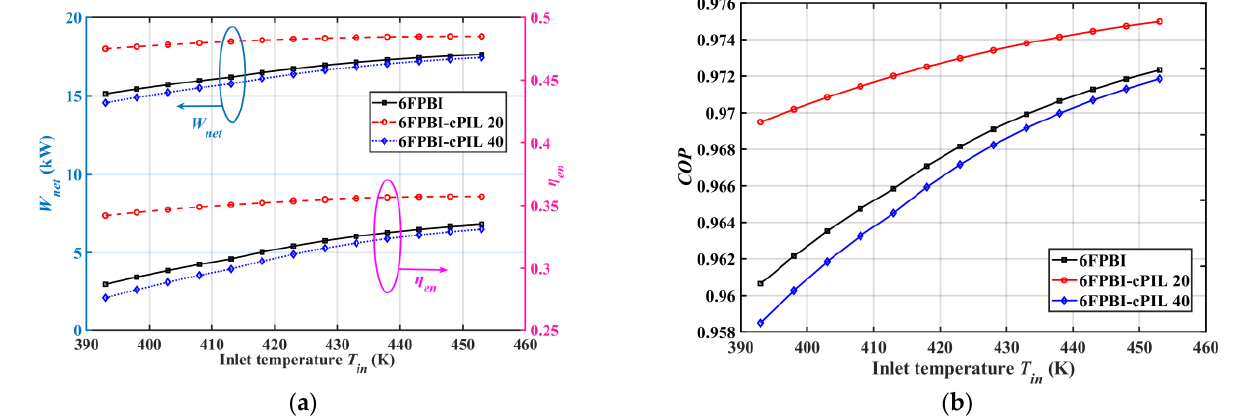
Figure 4. Variation of system performance with inlet temperature: ( a ) output power 𝑊 𝑛𝑒𝑡 and energy efficiency 𝜂 𝑒𝑛 ; ( b ) the coefficient of performance 𝐶𝑂𝑃 .